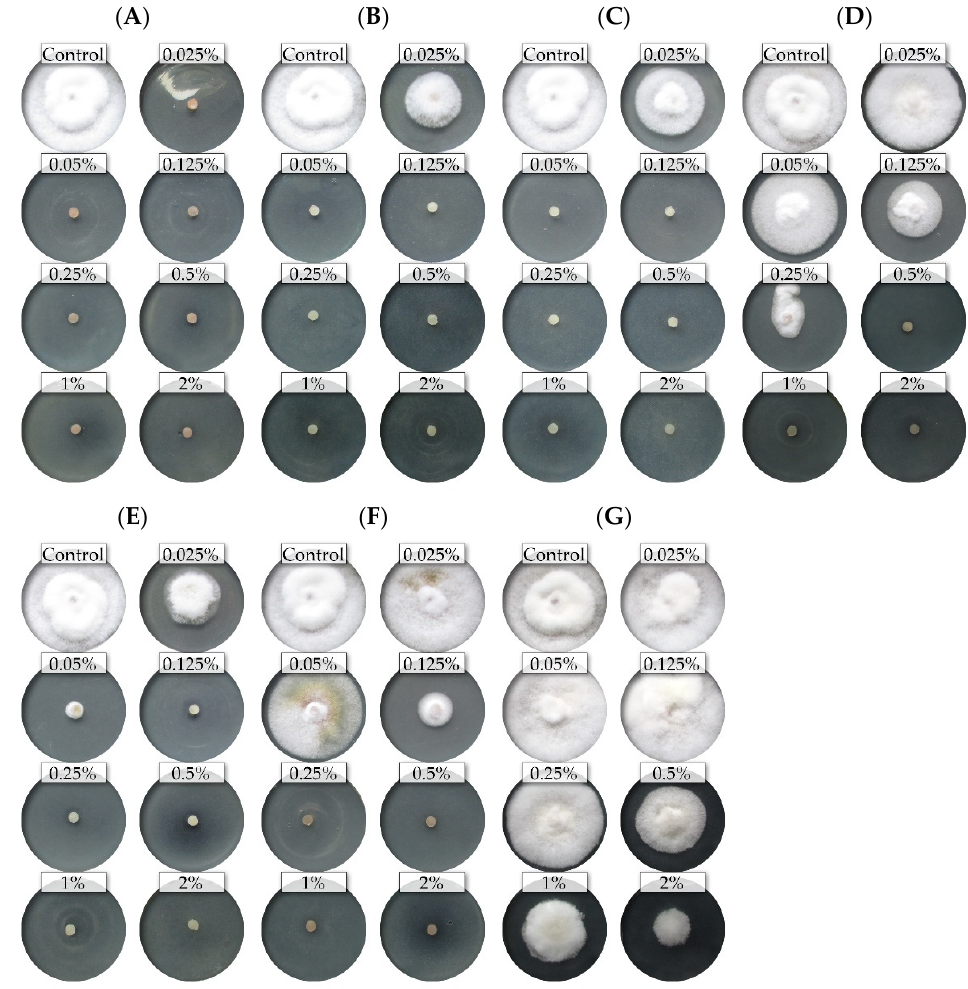
Figure 2. The effects of the different concentrations of the essential oils on the mycelial growth of the Fusarium poae FP0D: ( A )—thyme (T); ( B )—lemongrass (L); ( C )— Litsea cubeba (LC); ( D )—cajeput